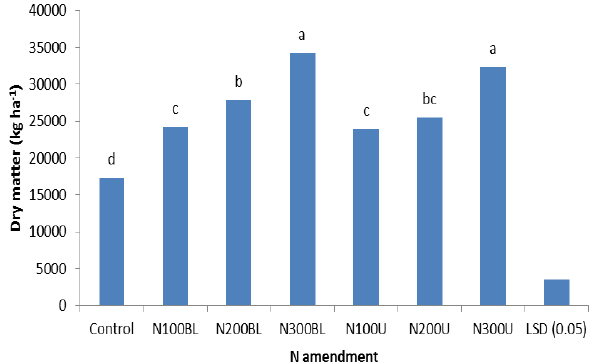
Fig. 10. The effects of N source and rate on dry matter concentration of silage corn. Means with the different letters show significant difference (LSD, P ≤ 0.05). See Fig. 2 for